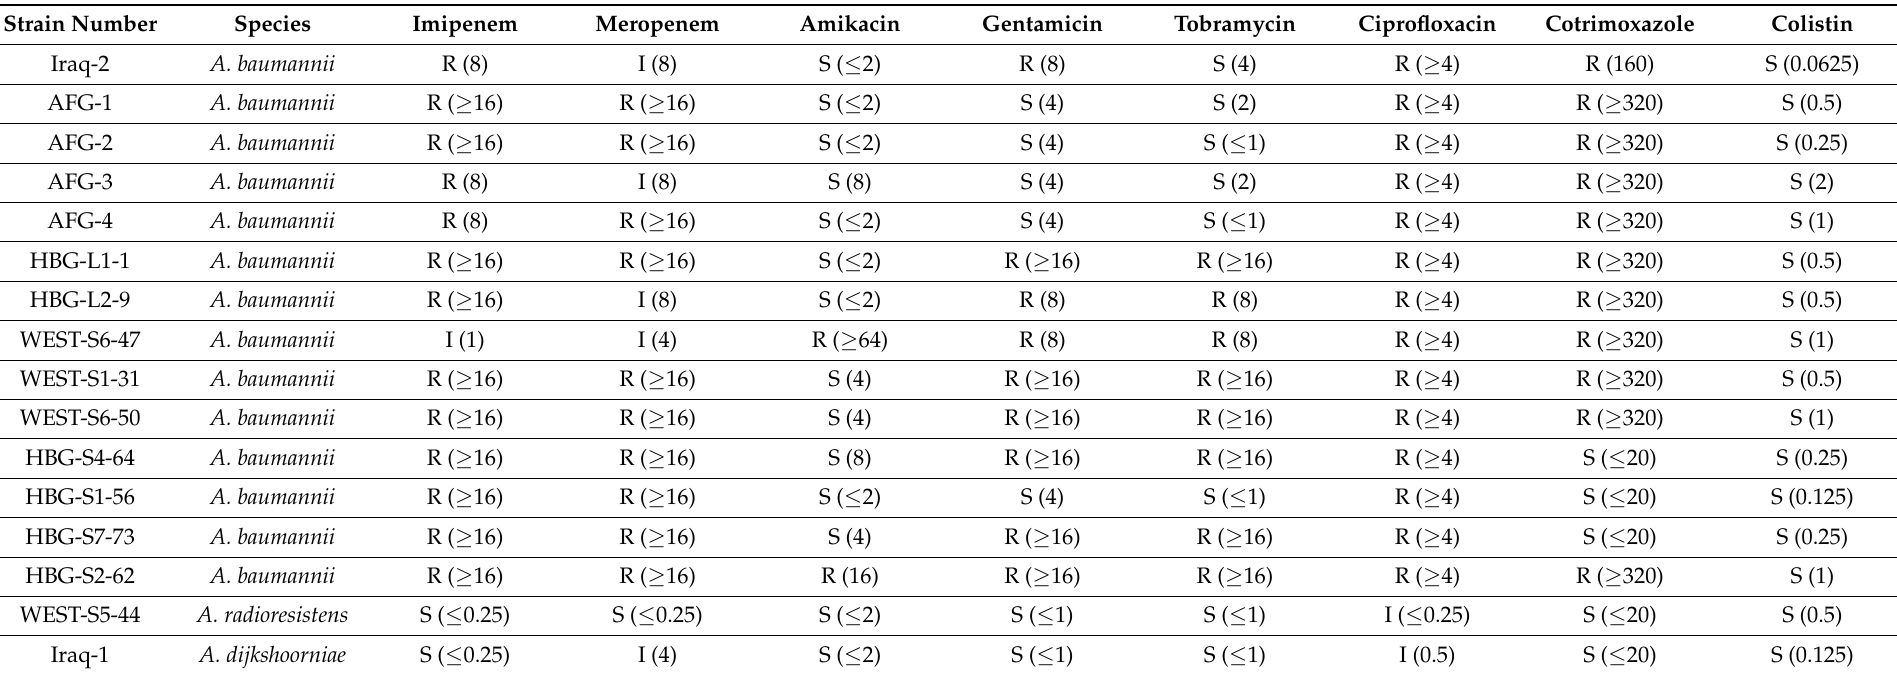
Table A2. Phenotypic resistance testing of the Acinetobacter spp. isolates based on micro-broth dilution (applied for colistin) and automated resistance testing using a VITEK-II device (BioM é reux, Nürtingen, Germany; applied for all other assessed antimicrobial substances). MICs (minimum inhibitory concentrations) in µ g/mL are shown in brackets. Interpretation was performed according to EUCAST NAK (European Committee on Antimicrobial Susceptibility Testing “Nationales Antibiotia-Sensitivitätstest-Kommittee”). S = susceptible. I = Susceptible at increased dosage. R = Resistant. N.d. = not